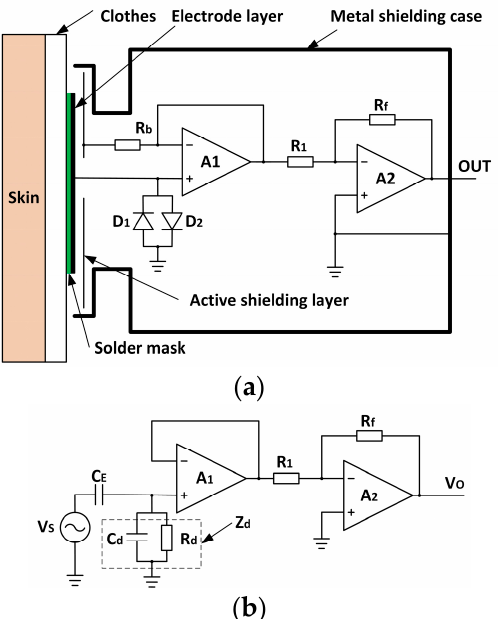
Figure 1. Sensing electrode: ( a ) Electrode structure; ( b ) Circuit model.